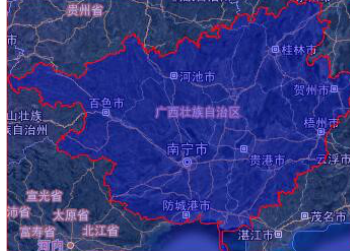
Figure 3. This part of the coverage is the vector of Guangxi. The overlapping part of quantum format and image is extracted by AcrToolbox and Spatial Analysis tool. After the extraction, the mask is extracted as shown in Figure 4.